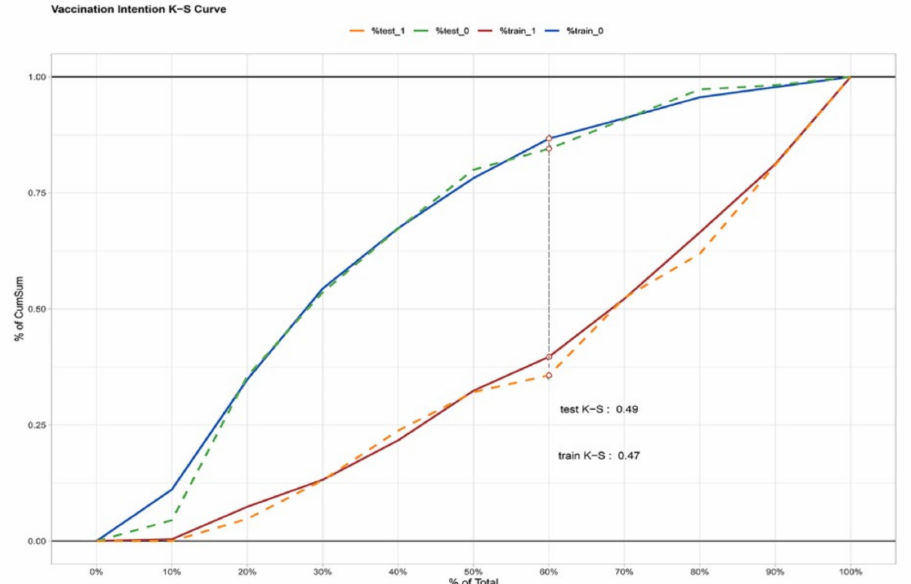
Figure 4. The K–S values in the training set and test set. The K–S values of the vaccination intention prediction model. The red line represents the positive performance of the model in the training set, and the blue line represents the negative performance of the model in the training set. The green line represents the negative performance of the model in the test set, and the orange line represents the positive performance of the model in the test set.